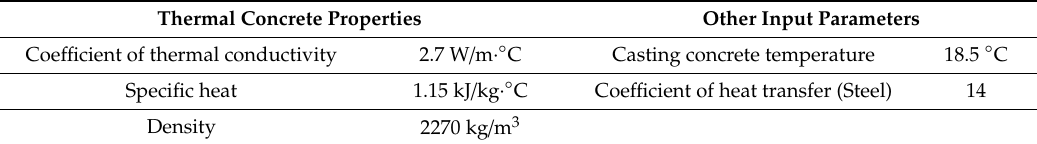
Table 8. Other input parameters for thermal and stress analysis using 3D FEM.